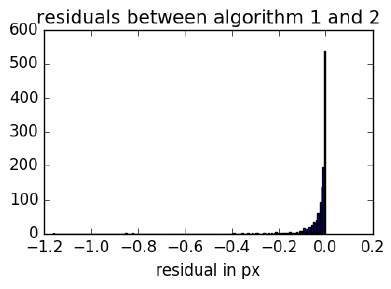
Figure 14. Histograms of the residuals between algorithm 1 and algorithm